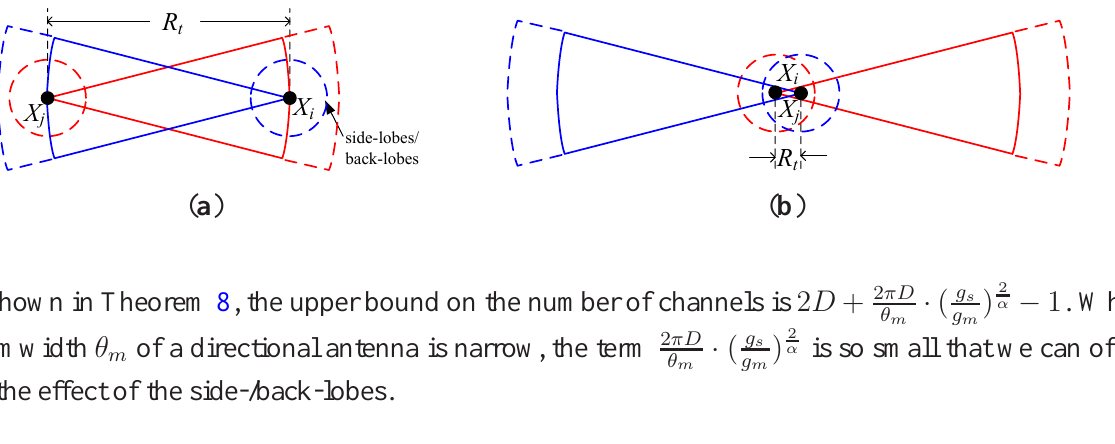
Figure 12. Two cases for Theorem 8. ( a ) Case 1; ( b ) Case